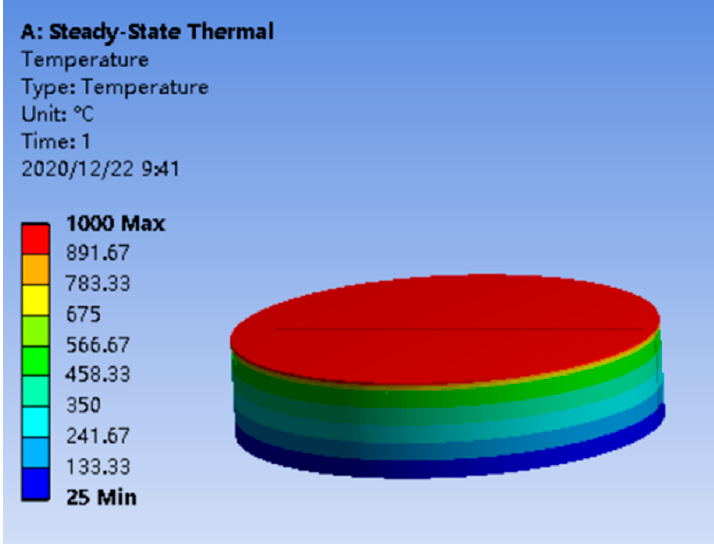
Figure 7. Temperature distribution cloud.